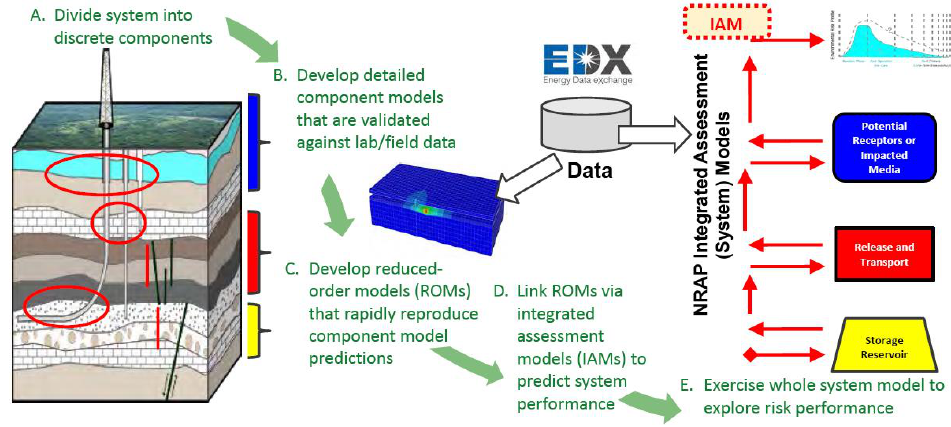
Figure 6. The framework of the National Risk Assessment Partnership (NARP) [144].